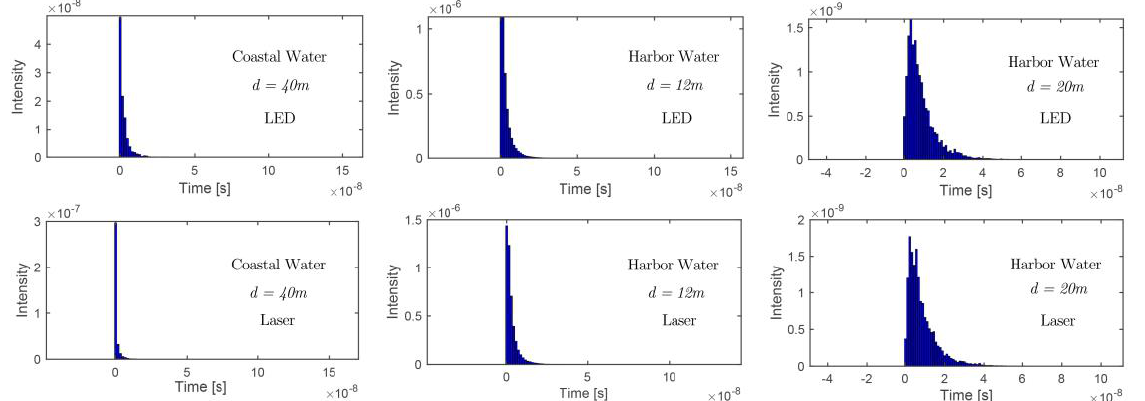
(f) Figure 7. Spatial illumination distribution at the received square plane for LED-based diffusive link in ( a ) 10 m coastal water, ( b ) 5 m harbor water, ( c ) 6 m harbor water, and Laser-based collimated link in ( d ) 35 m coastal water, ( e ) 5 m harbor water, ( f ) 6 m harbor water. 3.3. Statistical Attenuation As we mentioned before, the Beer–Lambert law overestimates the link attenuation because it abandons all the scattered photons that have possibilities to return to the aperture, especially in the coastal and turbid harbor waters. Thus, we investigated the deviation of the BL path loss by exploiting the numerical simulation. After the simulation, the link attenuation is determined by 𝑃𝐿(𝑑𝐵) = lg(∑ 𝑊 𝑖𝑁 𝑟 𝑖=1